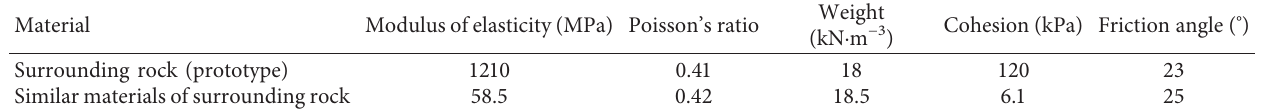
Table 6: Physicomechanical parameters of surrounding rock similar material.